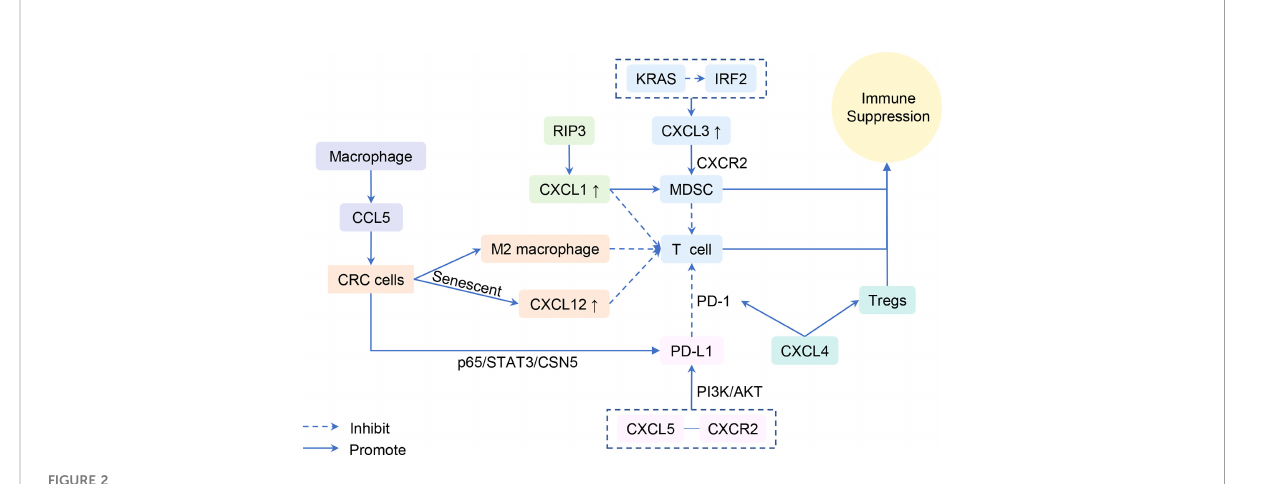
FIGURE 2 Chemokines are involved in the immune